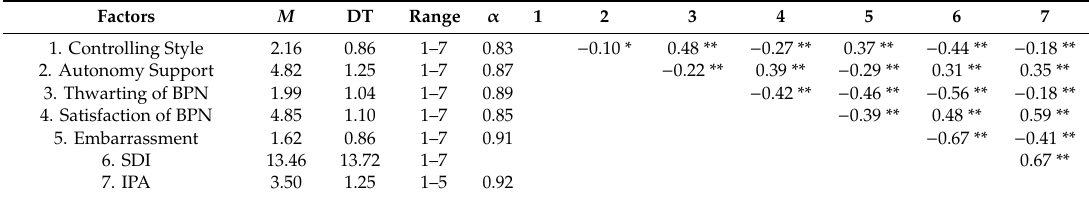
Table 1. Statistics and correlations between all